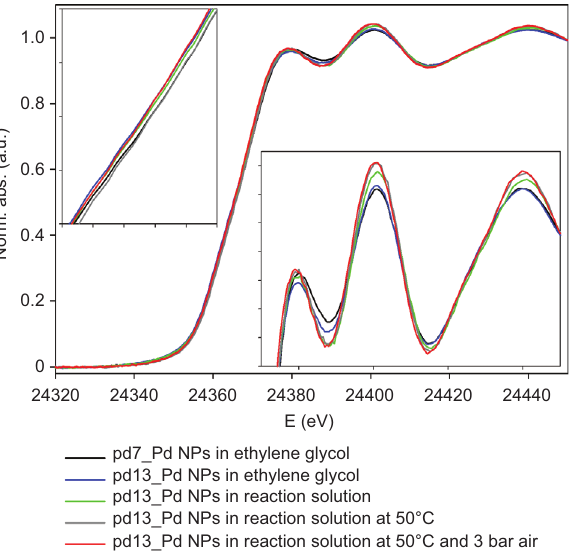
Figure 8 XANES spectra of the samples Pd7 (black), Pd13 in ethylene glycol (blue), Pd13 in isopropanol/water (green), Pd13 in isopropanol/water at 50 ° C (gray), Pd13 in isopropanol/water at 50 ° C with 3 bar synthetic air (red). The edge area and first resonances after the edge are shown